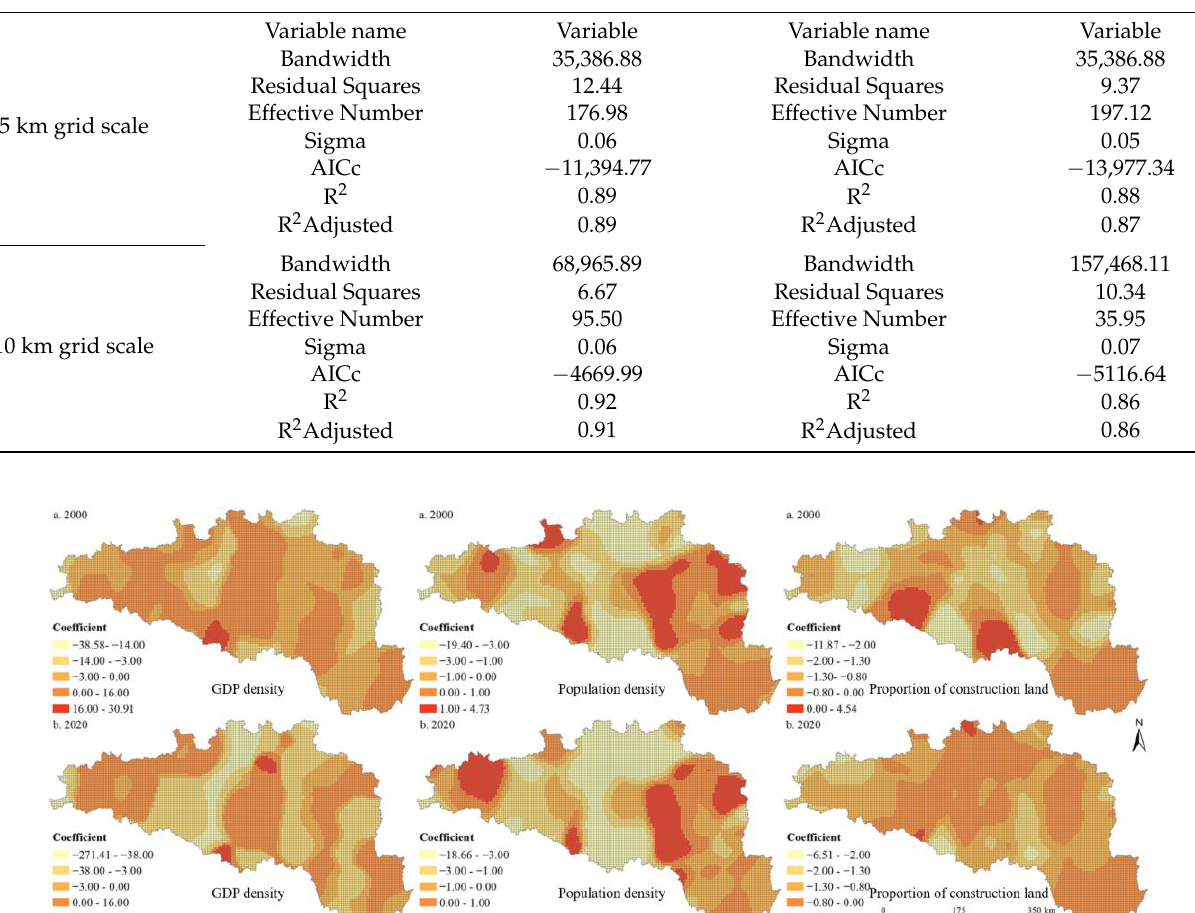
Figure 8. Spatial distribution of the regression coefficient of the urbanization elements at the 5 km grid scale in the HREEB in China.